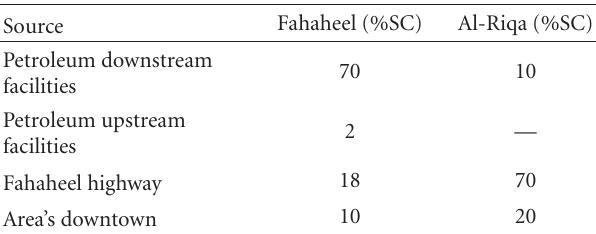
Table 7: source contribution in Al-Riqa and Fahaheel urban areas based on CMB model results averaged over the period of the study.